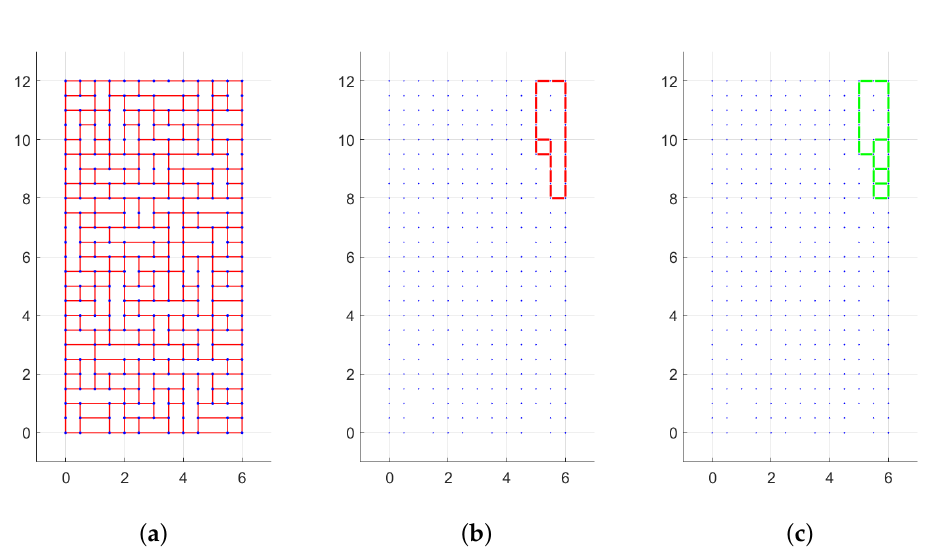
Figure 12. Chaotic masonry with H / W = 2: ( a ) texture, ( b ) layout of displacements ( s ) for right oriented force, ( c ) layout of rotations ( w ) for right oriented force. (Dimensions expressed in units.)